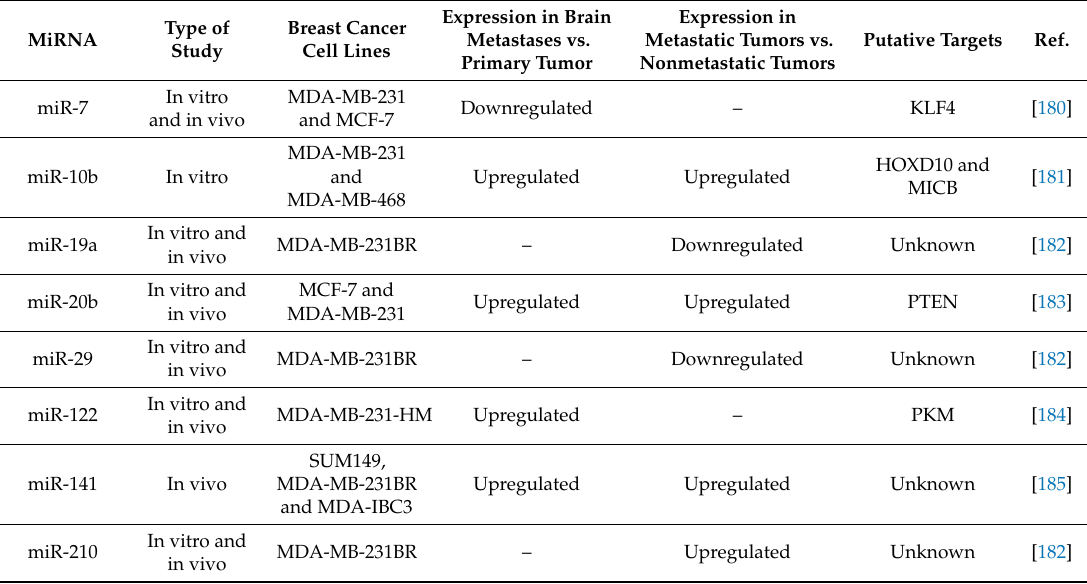
Table 1. MiRNAs associated with breast cancer brain metastases and their expression in cancer cells. Expression in Brain Expression in Type of Breast Cancer MiRNA Metastases vs. Metastatic Tumors vs. Putative Targets Ref. Study Cell Lines Primary Tumor Nonmetastatic Tumors